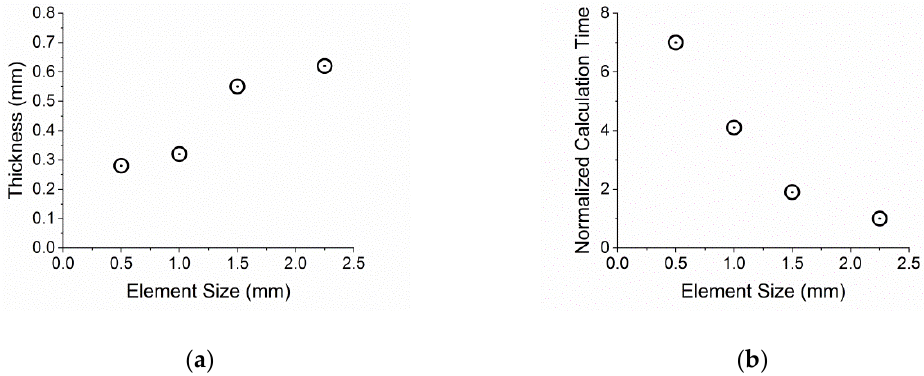
Figure 6. The impact of element size on ( a ) minimum thickness; ( b ) calculation time.